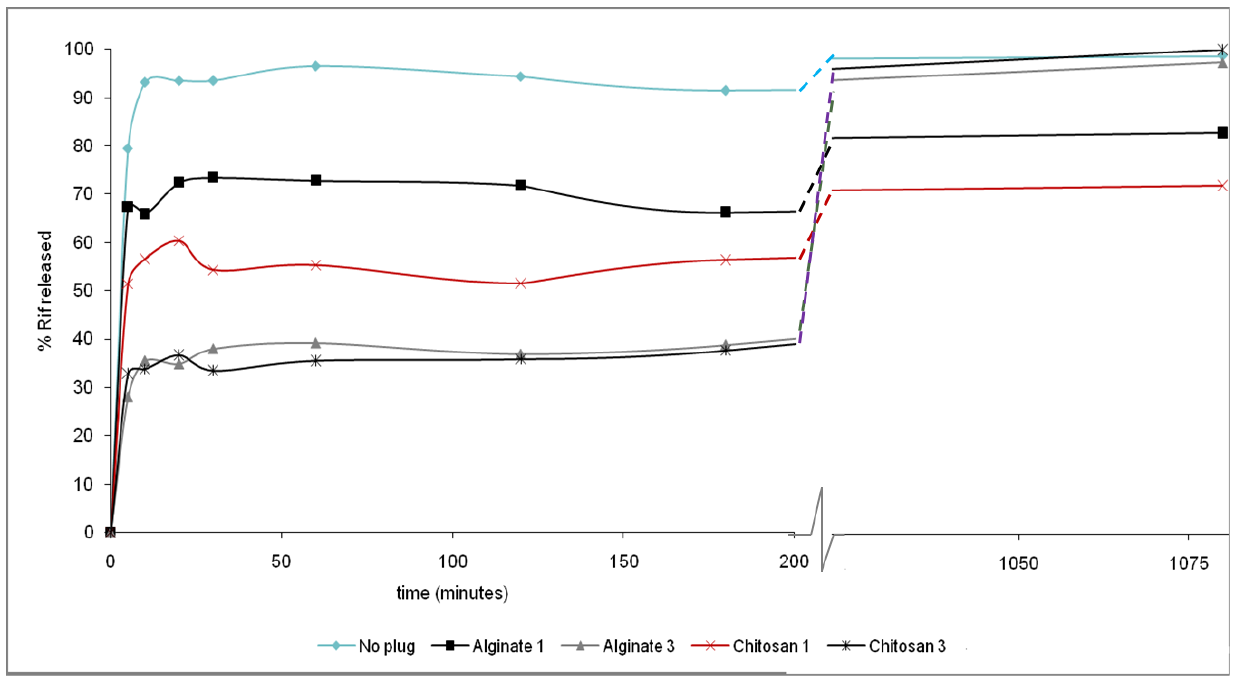
Figure 2. % of Rif released from unsealed and sealed GP formulations at pH 7. Results correspond to samples containing 10% w/w Rif/GP and were sealed with 0, 1 or 3 layers of the indicated